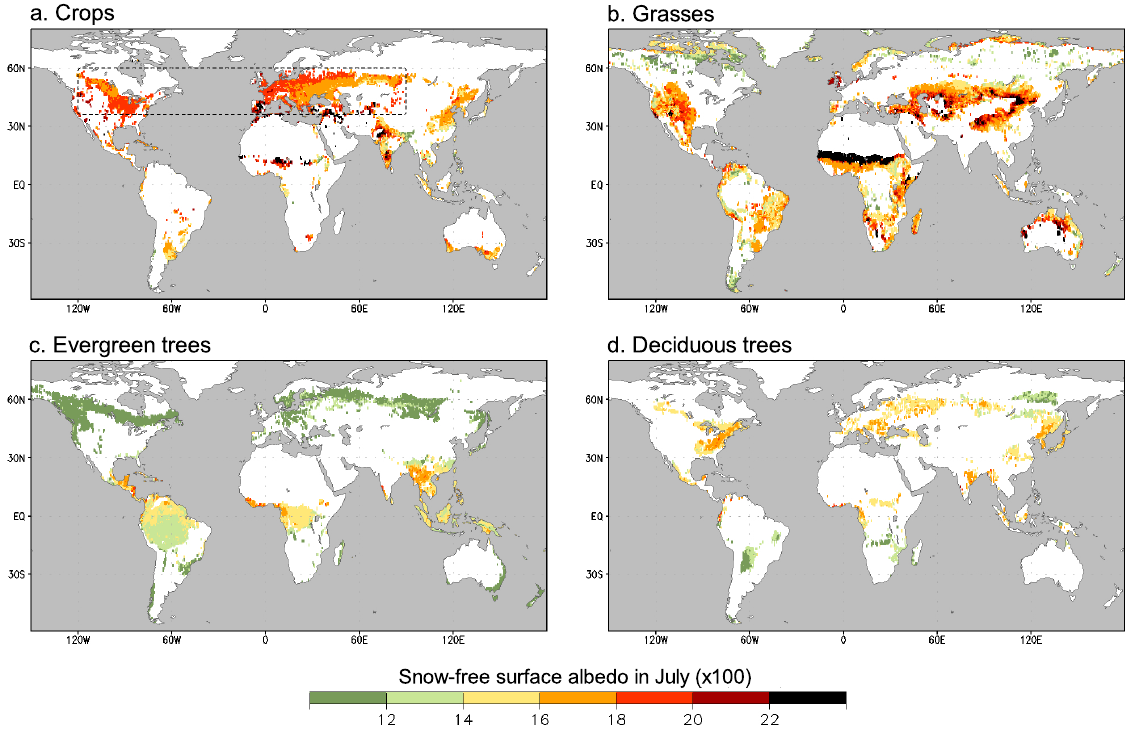
Fig. 2. Snow-free surface albedo in July derived from MODIS. Maps indicate the available grid cells of 0.5 ◦ (containing sub-cells with dominant land cover; see text) associated to four land cover groups used in this study: crops (a) , grasses (b) , evergreen trees (c) and deciduous trees (d) . Dashed box in (a) encompasses the land area of large deforestation between 1870 and 1992 further used for specific